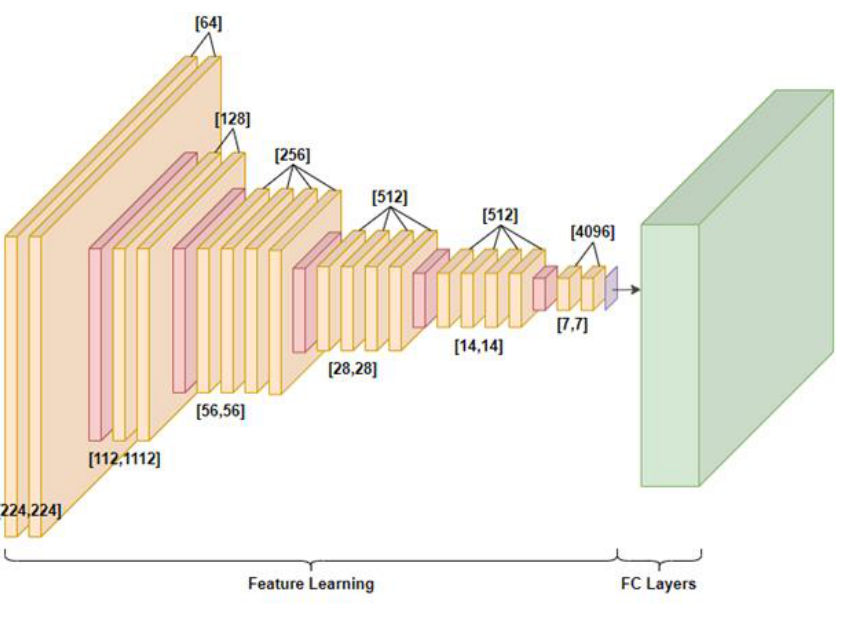
Figure 3. VGG-19 architecture. Table 2. A summary of the VGG-19 architecture in terms of input size requirements for every layer of the